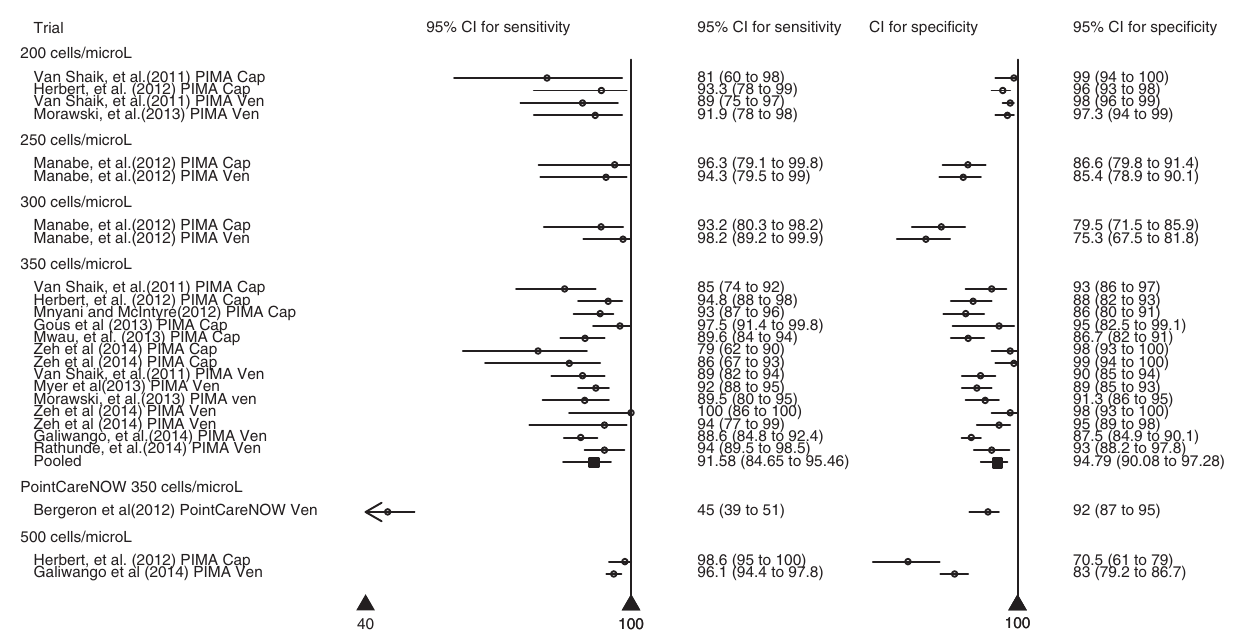
Figure 4. Accuracy results. Forest plot and pooled results, grouped by substrate used and POC